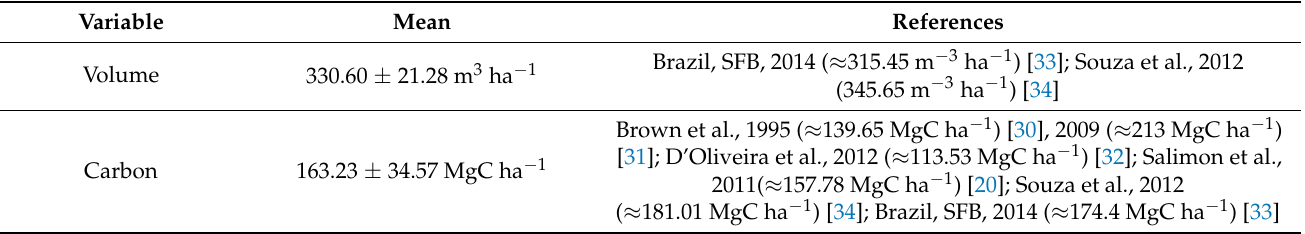
Table 2. Volume and carbon inferred from previous studies in the southwestern portion of the Brazilian Amazon for trees of all species with DBH ≥ 10